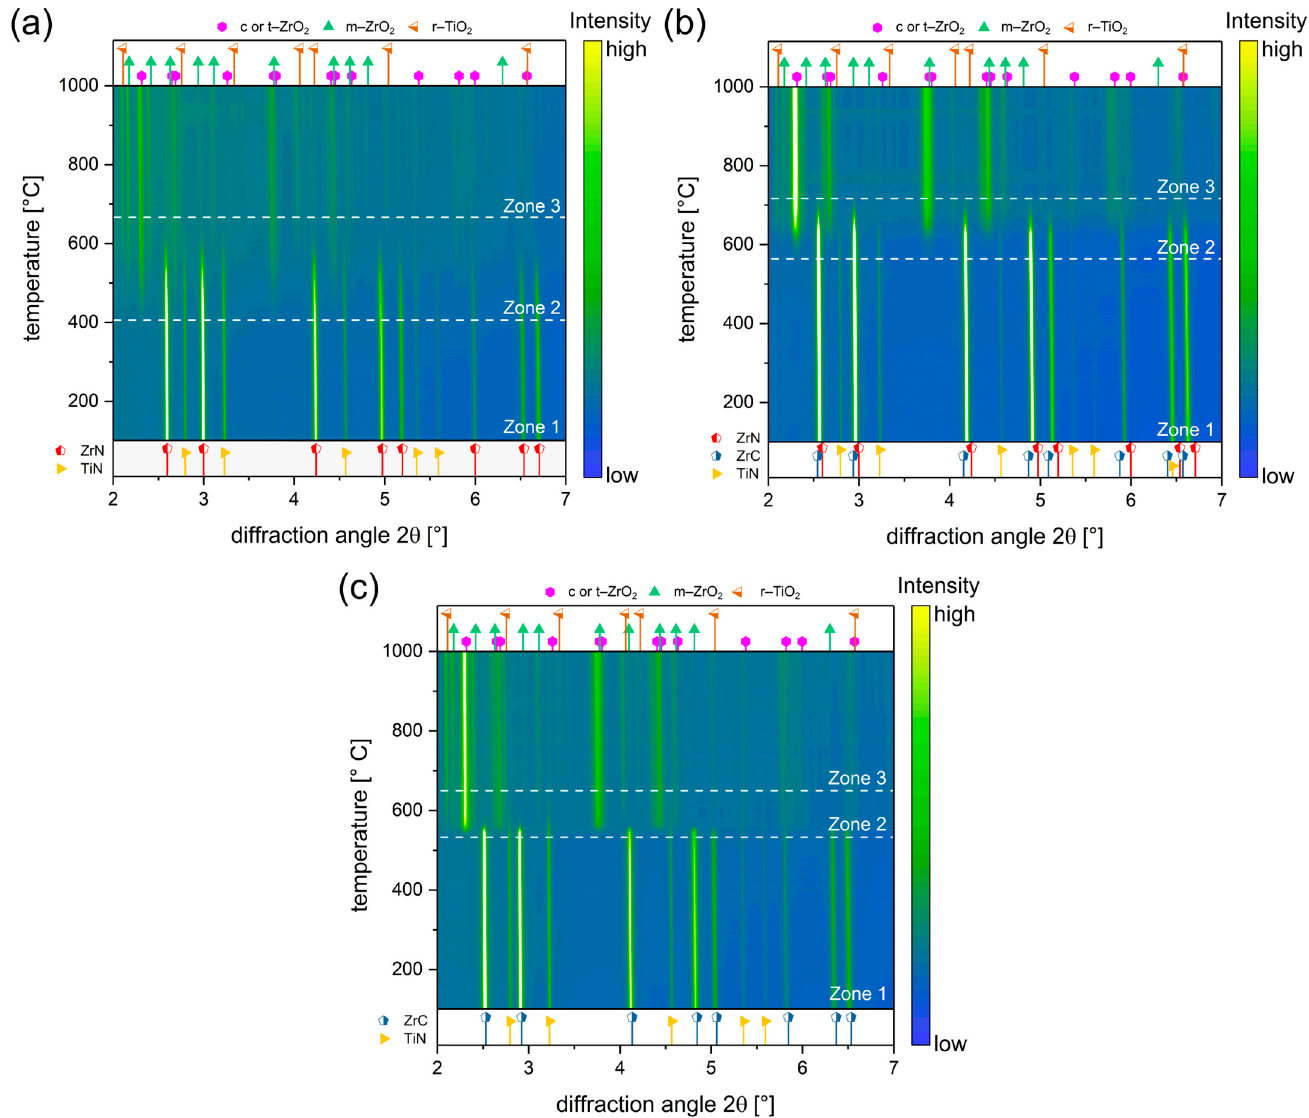
Figure 3. Phase plots of the modelled in-situ powder XRD data as a function of the oxidation temperature for the ( a ) ZrN, ( b ) ZrCN and ( c ) ZrC sample. The intensity of the diffraction data is colour